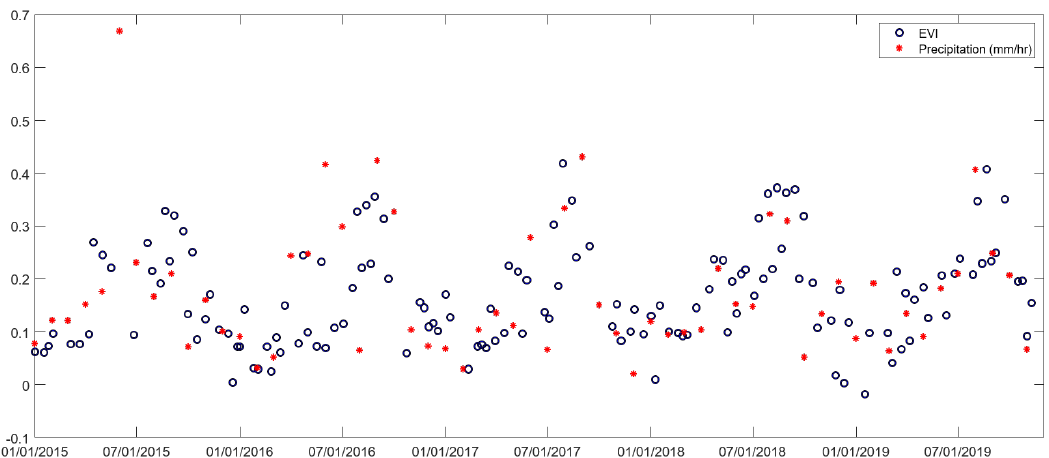
Figure 4. Temporal variations of rainfall rate and vegetation index for Chongming island in the period of 2015–2019. Here, enhanced vegetation index (EVI) is used for the vegetation cover data derived from Landsat 8. The precipitation data are sourced from Tropical Rainfall Measuring Mission (TRMM) 3B43 rainfall products